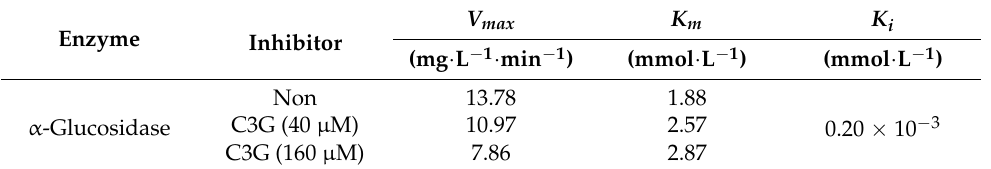
Figure 4. Lineweaver–Burk plot for determining the kinetic constants for α -glucosidase. Table 2. V max and K m values of the interaction between C3G and α‐ glucosidase.